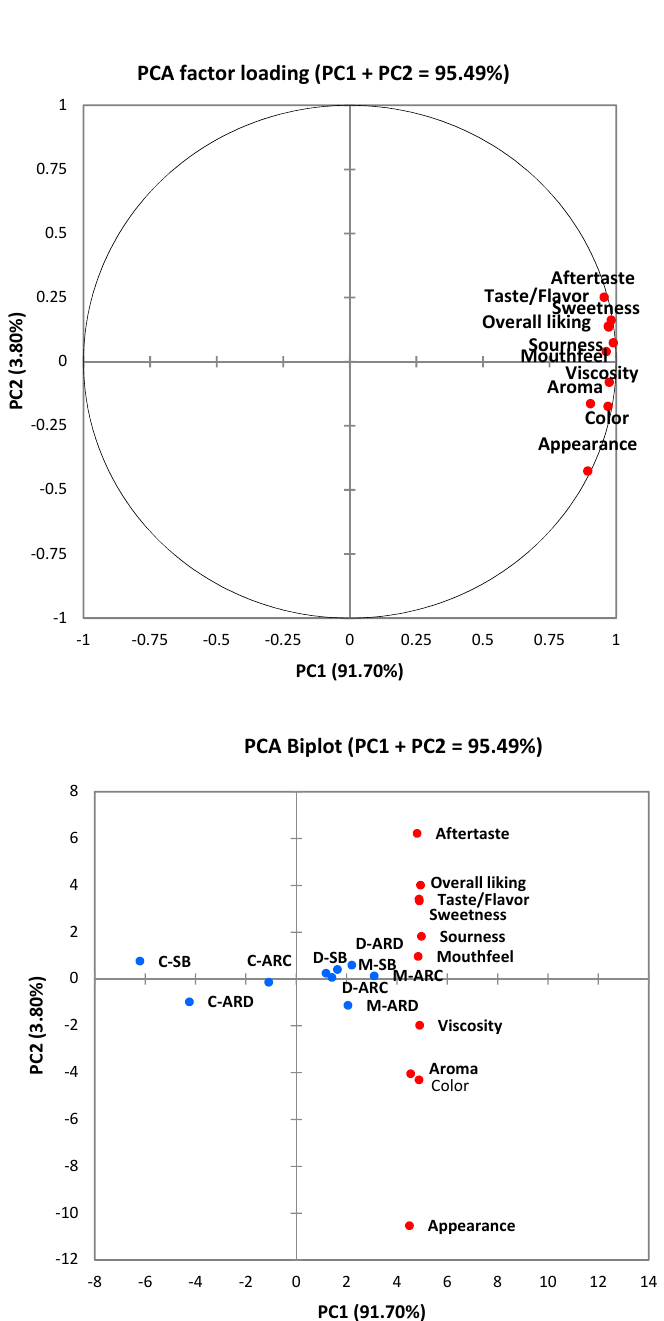
Figure 5. Principal component analysis (PCA) biplot regarding hedonic scores of yogurt attributes under the three contextual settings. The description of the treatment’s labels can be found in the footnote of Table 2.